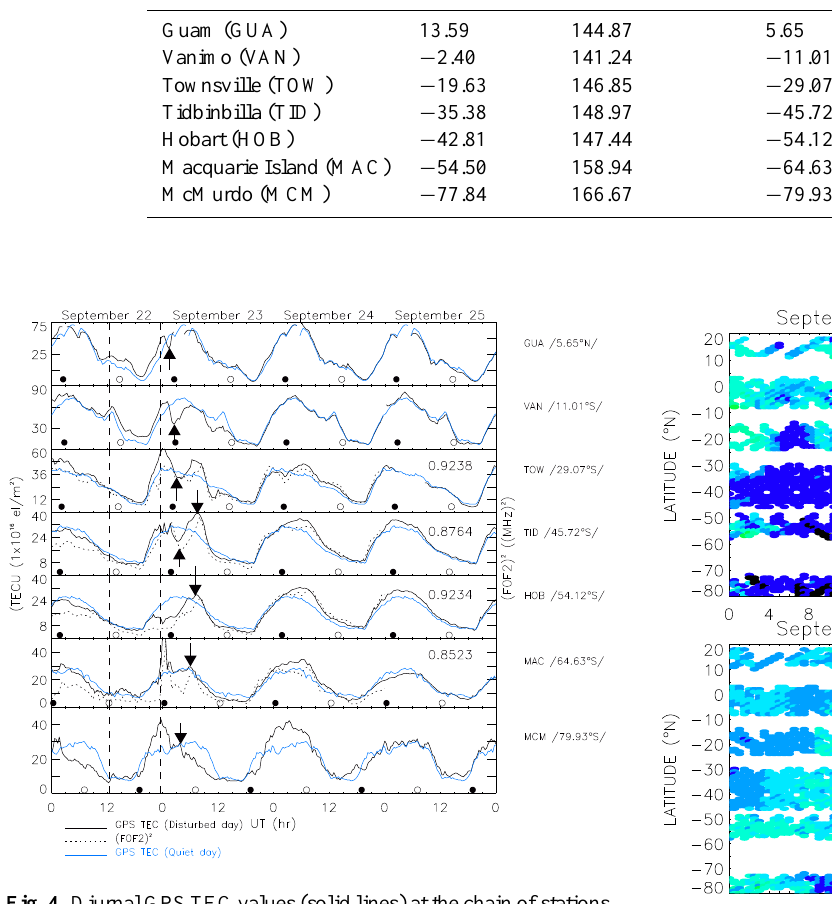
Fig. 4. Diurnal GPS TEC values (solid lines) at the chain of stations and ionosonde (f 0 F 2 ) 2 data (dotted lines) over Townsville, Tidbn- bila, Hobart and Macquarie Island. f o F 2 data was not available from the remaining stations to present comparison. Vertical broken lines at the left and right, respectively, depict the SSC time and TEC enhancement peaks that occurred nearly simultaneously ( < 1/2h).